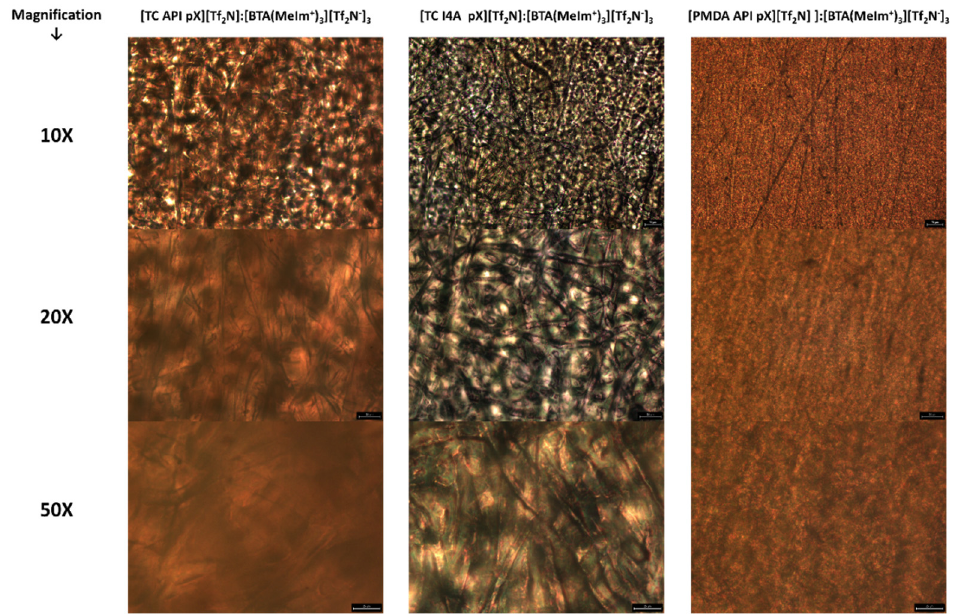
Figure 7. PLM images of PA and PI ionene composites with [BTA(MeIm + ) 3 ][Tf 2 N − ] 3. Materials showed ordered structures and were probed as thin films, at 10 × , 20 × , and 50 × magnifications (scale bar, top to bottom: 75 µ m, 50 µ m, 25 µ